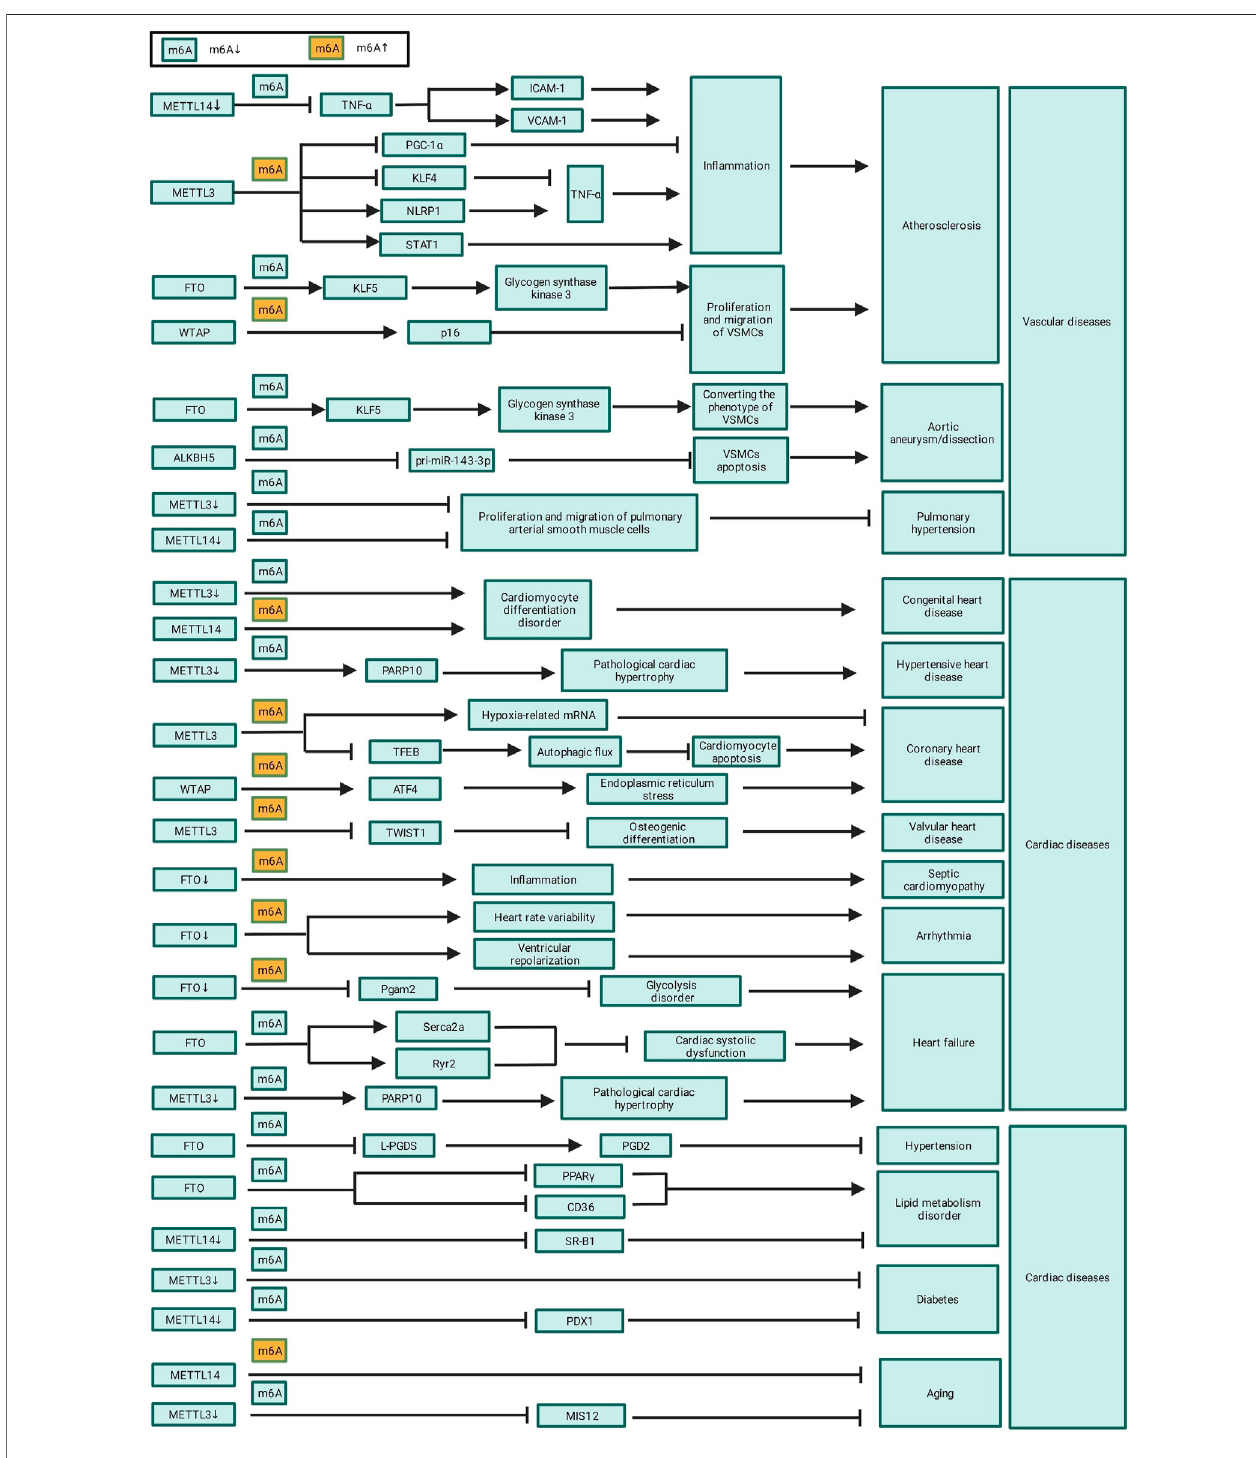
FIGURE 2 | The role of m6A in CVD.